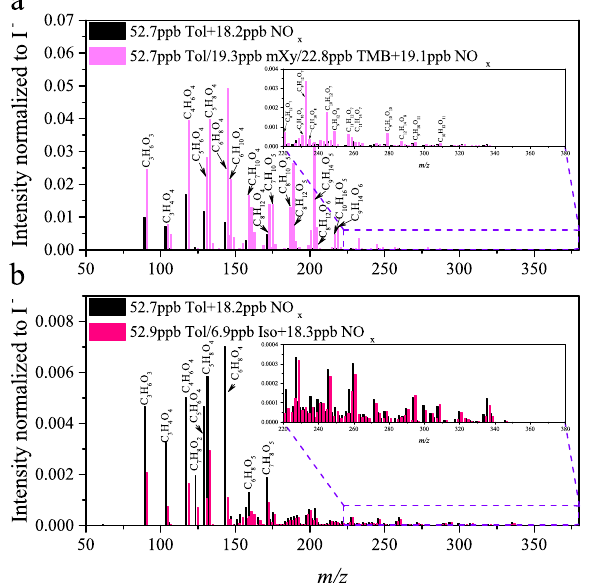
Fig. 2 Comparison of the gas-phase mass spectra. Gas-phase mass spectra derived from the photochemical experiments under different mixed VOC scenarios (i.e., toluene, mixed toluene and isoprene, as well as mixed toluene, m-xylene, and 1,3,5-trimethyl- benzene) in the presence of NO x (~20 ppb) at higher VOC concentration levels. a toluene vs. mixed AVOC scenario and b toluene vs. mixed AVOC/BVOC scenario. Intensities were normal- ized to the ion source iodide. The assignments of detected ions to individual species were speculated considering iodide-CIMS has an inability to directly provide structural